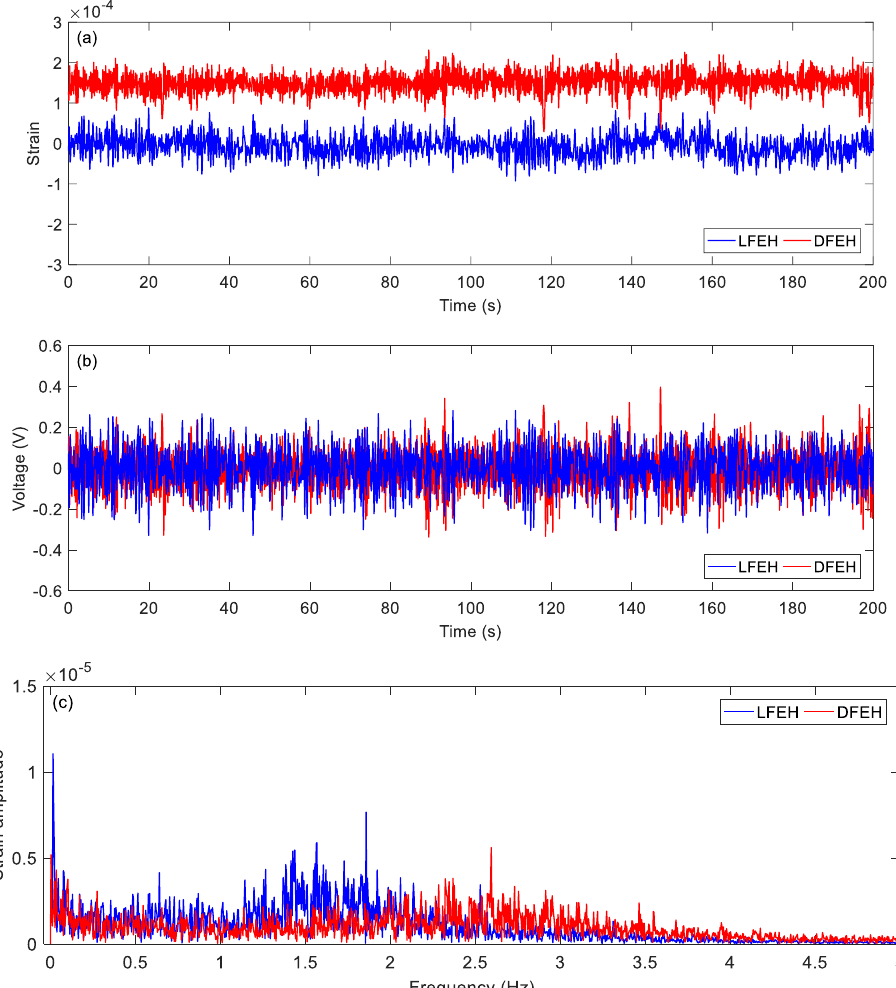
Figure 8. ( a ) Time histories of strain response, ( b ) time histories of voltage response, ( c ) spectrum of dynamic strain response ( 𝑣 = 1.5 m/s).